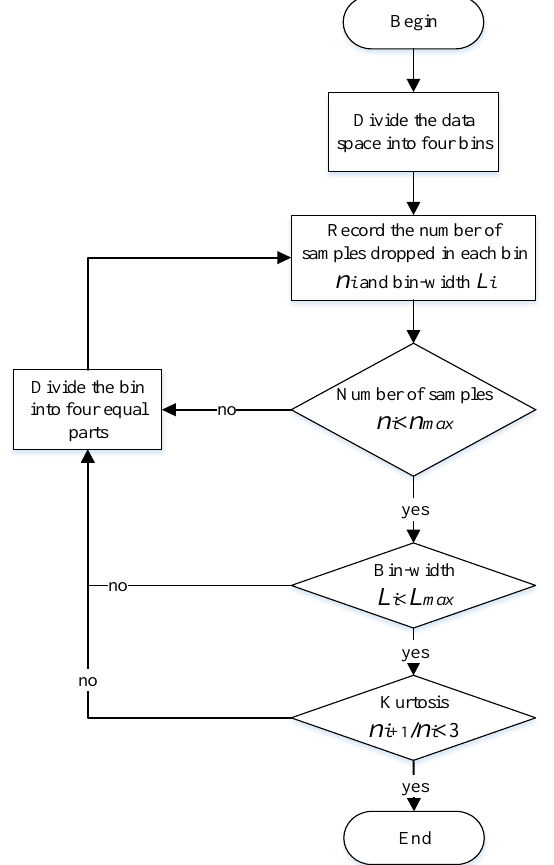
Figure 1. Univariate adaptive binned method based on quadtree algorithm.